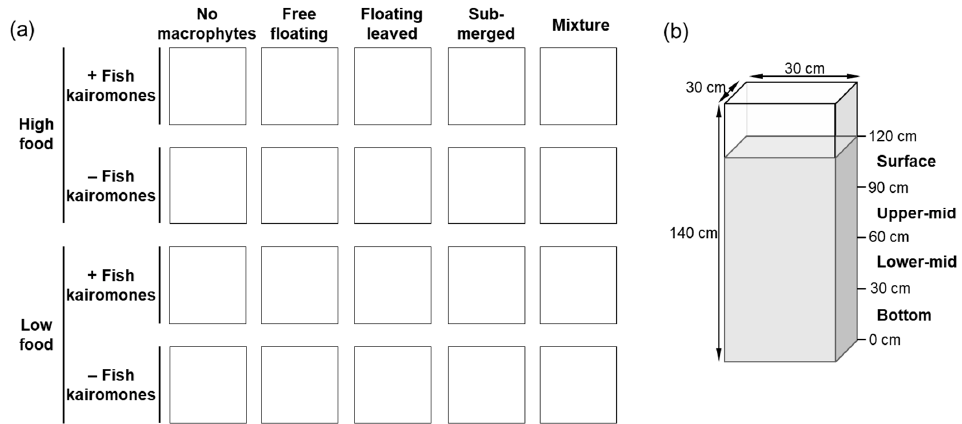
Figure 3. Design of the microcosm experiment. Three factors—macrophyte type, presence of fish predation, and food availability—were simultaneously considered to investigate the distribution of the two cladoceran species at four depths. ( a ) Allocation of experimental groups, ( b ) shape of microcosm tank, length, 30 cm; width, 30 cm; height 140 cm. The microcosm tanks were filled with Elendt M4 medium up to 120 cm, and the medium-filled space was separated into four layers according to depth.